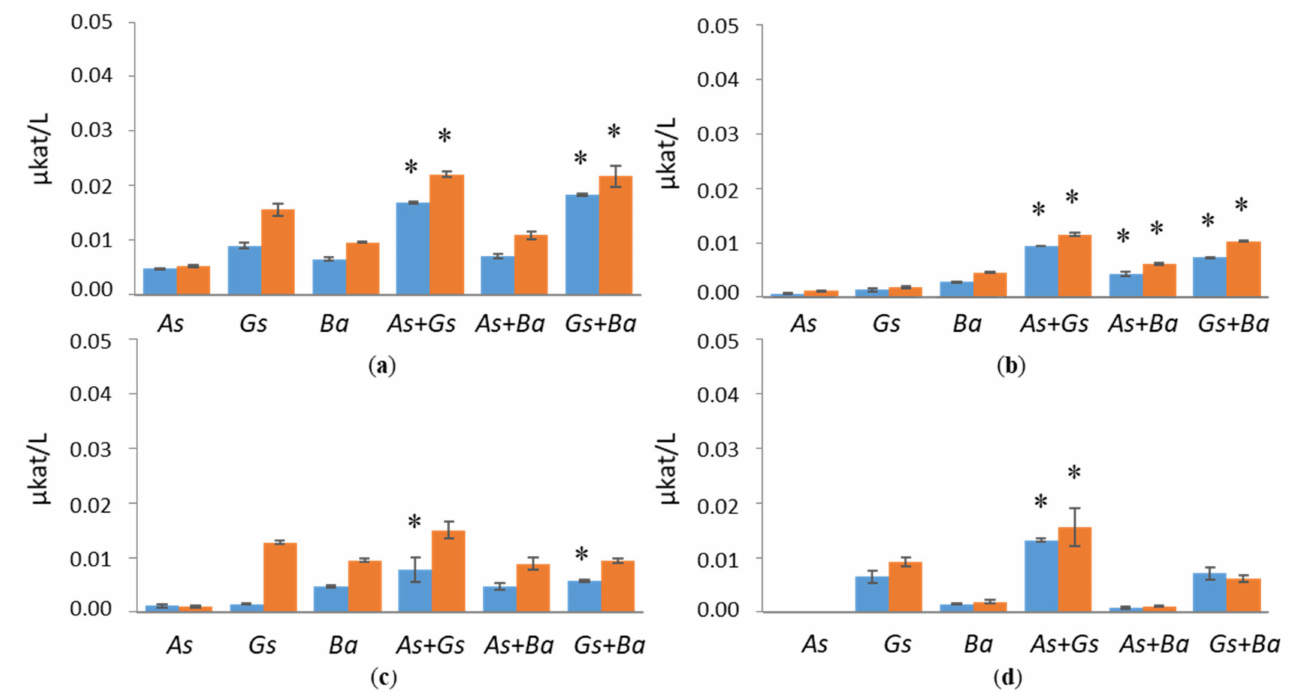
Figure 5. β -xylosidase (BXL) activities at early (day 10, marked in blue) and late time points (day 24, marked in red) in single and co-cultivation on ( a ) birch, ( b ) spruce, ( c ) pine wood and ( d ) Avicel. As = A. sinuosa , Gs = G. sepiarium , Ba = B. adusta , As + Gs = A. sinuosa and G. sepiarium , As + Ba = A. sinuosa and B. adusta , Gs+Ba = G. sepiarium and B. adusta . Error bars refer to standard deviation (SD) ( n = 3). * indicates statistical difference among single and co-cultivations ( p <